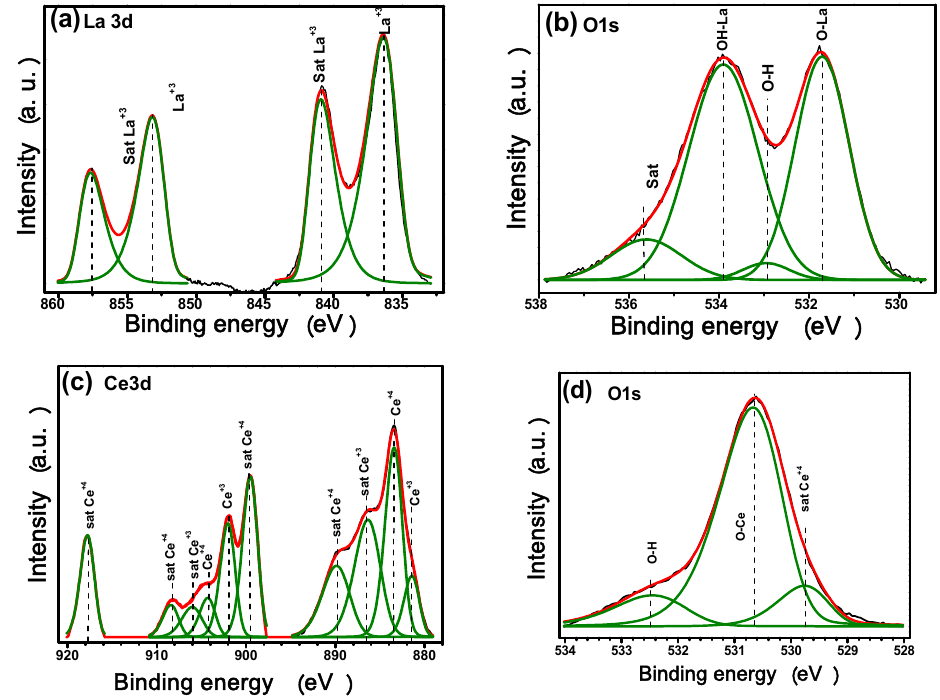
Figure 2. Representative high resolution XPS spectra of as-obtained samples at P 60 T 80 t 60 : ( a ) La 3d, ( b ) La O1s, ( c ) Ce 3d, and ( d ) Ce O1s. Table 2. Determination of Ce 4+ /Ce 3+ and La oxide/hydroxide ratios from XPS measurements. Sample Ce 4+ /Ce 3+ Ratio La Oxide/Hydroxide Ratio